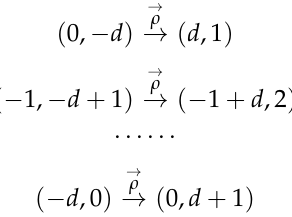
Figure 6. Coordinate transforming of BDLN G 2 .